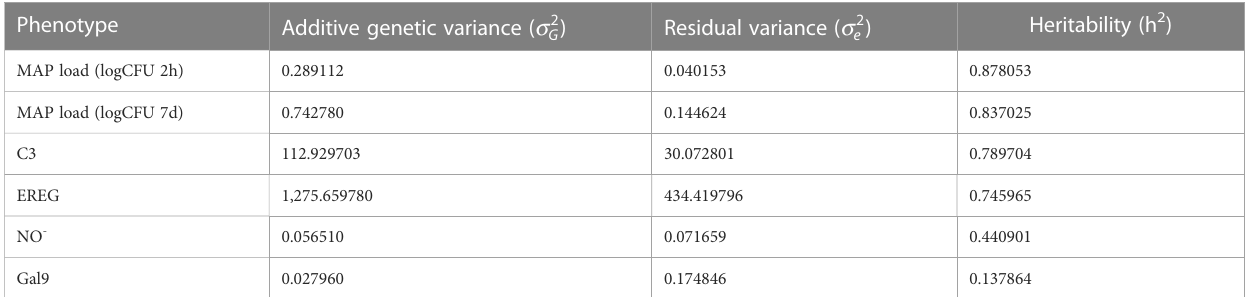
TABLE 2 Variance components and h 2 estimates for the intracellular MAP load within MDMs at 2 h and 7 d p. i., and the extracellular Gal9, EREG, C3, and NO -